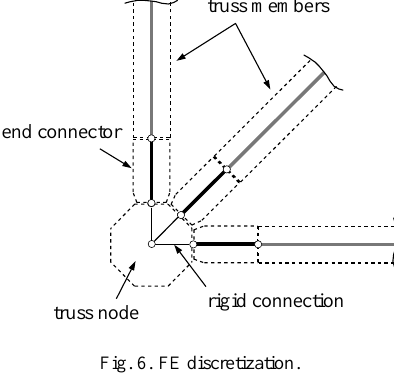
Fig. 6. FE discretization.